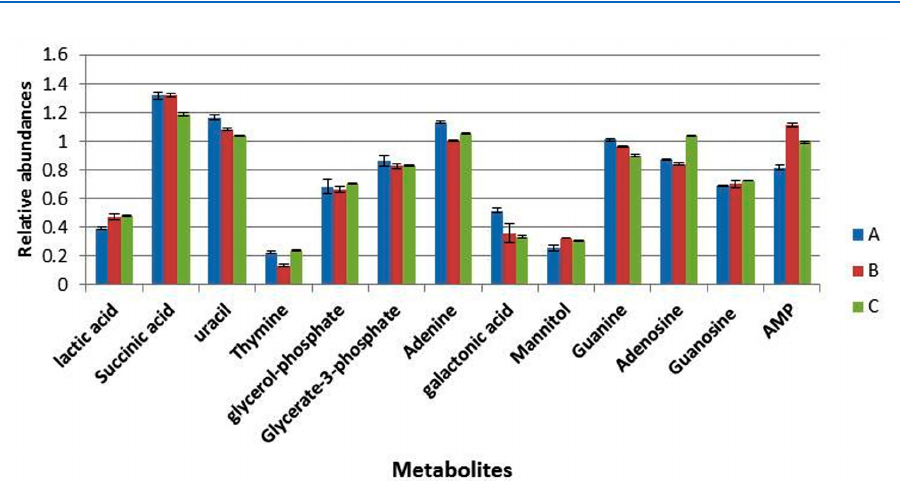
Fig. 3. The relative abundances of cytoplasmic metabolites extracted from clinical isolate of S. aureus harvested at mid-exponential from cells grown under normal conditions (A), , pH6, 35°C (B) and pH8 at 35°C (C).